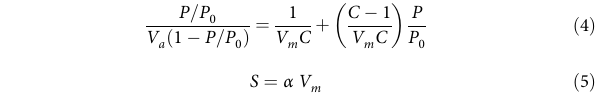
Fig. 2a. The PMN modi fi ed with a positively charged hydrogels (Supplementary Fig. 5) was prepared under the same polymerization condition as PAMPS but using